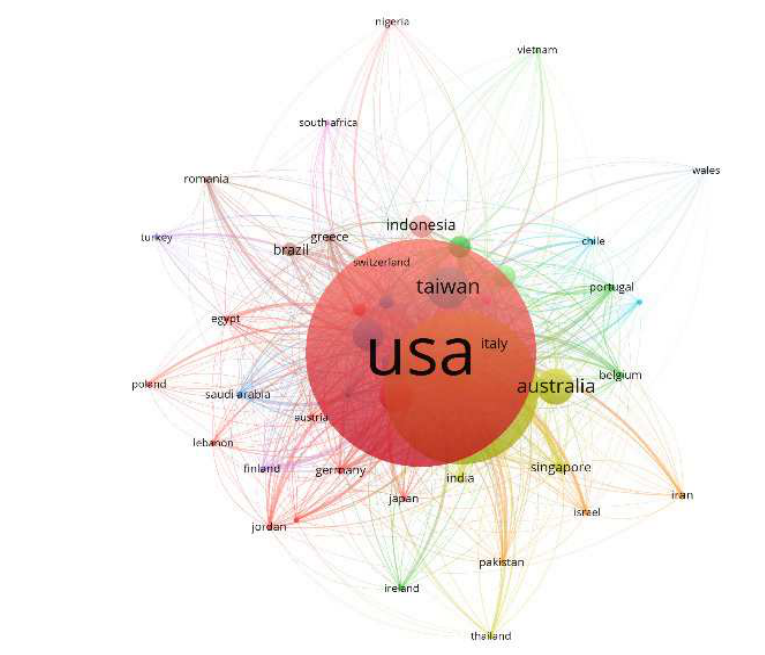
Figure 6. A science map of countries with the highest number of cited publications with the term “Earnings Management” from 1900 to 2019